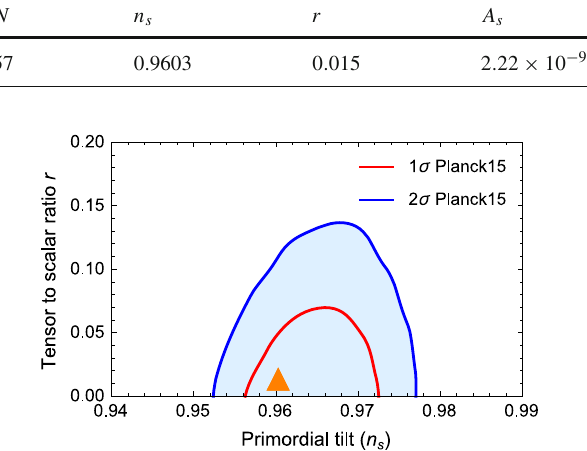
Fig. 7 A plot of the predictions for the scalar potential with F = 0, b = 3 / 2, A = 0 . 545, B = 0 . 230, ξ = − 1 . 140 and q = 2 . 121 × 10 − 5 in the n s - r plane, versus Planck’15